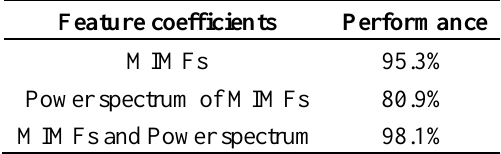
Table 2. Performance with different feature coefficients.